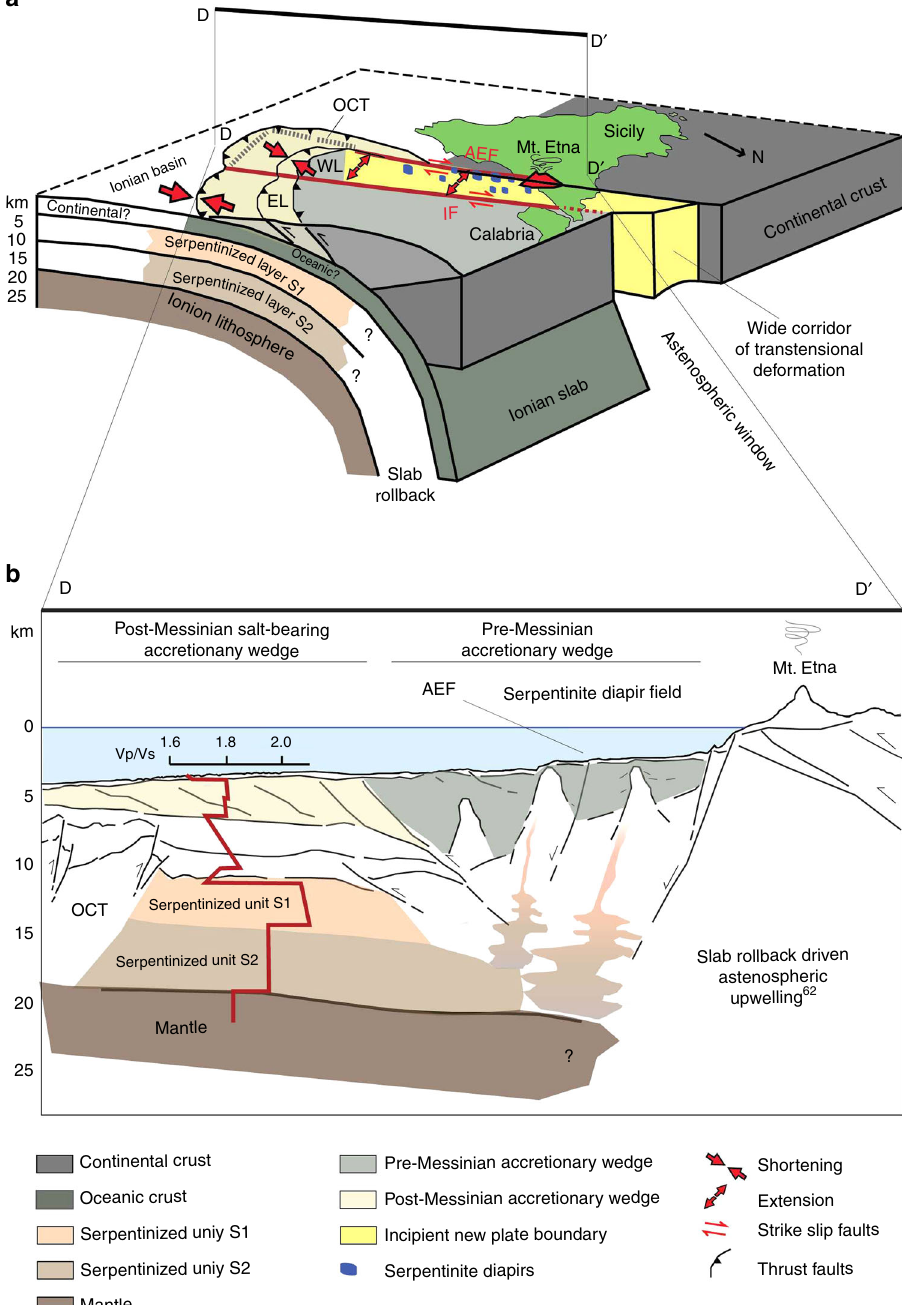
Fig. 8 Schematic block diagram and cross section of the Western Calabrian Arc. a Block diagram of the Western Calabrian Arc subduction complex showing relationships between deep slab, transtensional faults, serpentinite diapirs, and Mt. Etna volcano (modi fi ed from refs. 62,69 ). Faulting associated with arc-perpendicular extensional tectonics in the accretionary wedge (modi fi ed from ref. 17 ) is shown in the yellow corridor between the Ionian and Alfeo-Etna fault systems. Extensional processes and associated Mt. Etna volcanism could be related to vertical upwelling of the asthenosphere at the SW lateral edge of the Ionian slab 62,63,79 . At the edges of a retreating slab the toroidal component of asthenospheric fl ow may induce an upward fl ow and decompression melting which could explain the formation of Mt. Etna 2 . Transtensional processes along the rifting zone between the Alfeo-Etna and Ionian fault may drive inherited serpentinite diapirism during slab tearing processes. b Sketch of the margin structure orthogonal to the arc based on interpretation of available multichannel seismic and Vp/Vs data 26 . Section D-D ’ (location also indicated in Fig. 5) crosses the Calabrian Arc accretionary wedge, the inherited serpentinite diapir fi eld, and Mt. Etna implying structural control on both diapirism and Mt. Etna formation. AEF, Alfeo-Etna fault; EL, eastern lobe of the accretionary wedge; IF, Ionian fault; OCT, Oceanic-continental transition; WL, western lobe of the accretionary